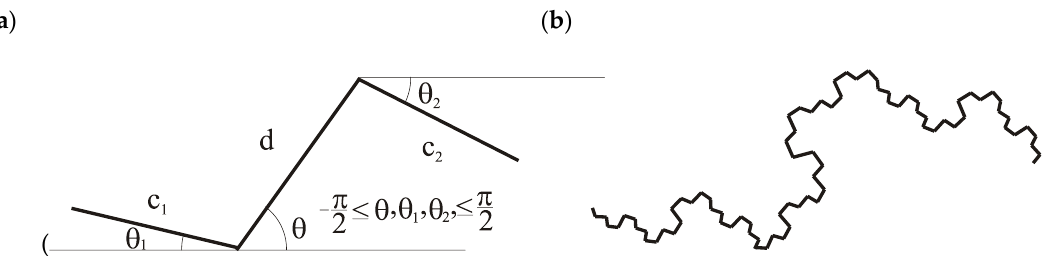
Figure 5. The generator shape proposed by Chang and others in the paper [42] ( a ) and the fractal obtained on its basis ( b ).